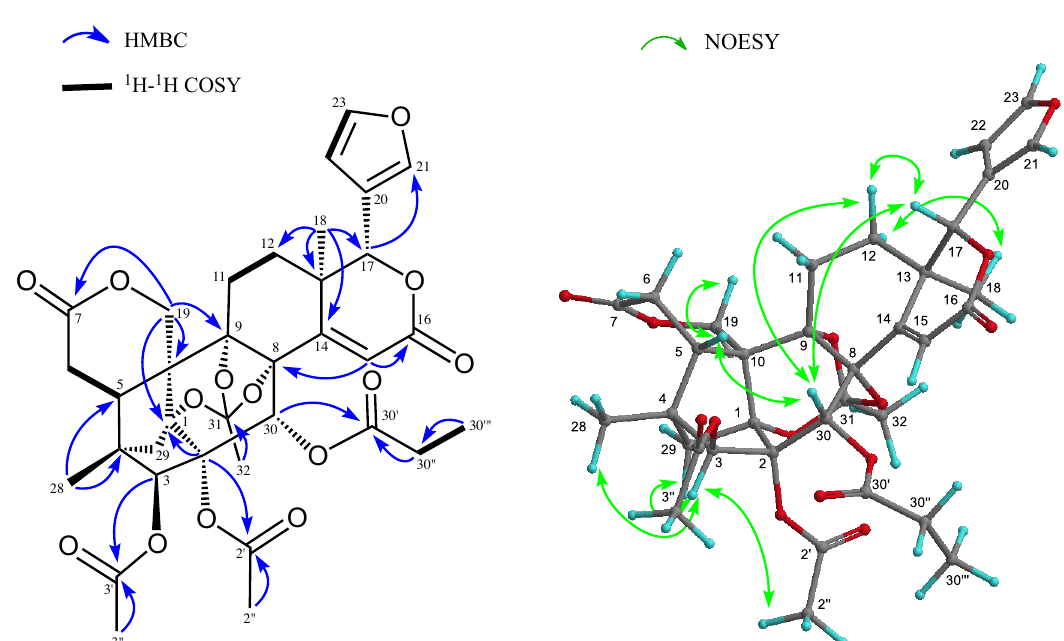
Figure 3. Key HMBC, COSY and NOESY correlations for carapanolide V ( 3